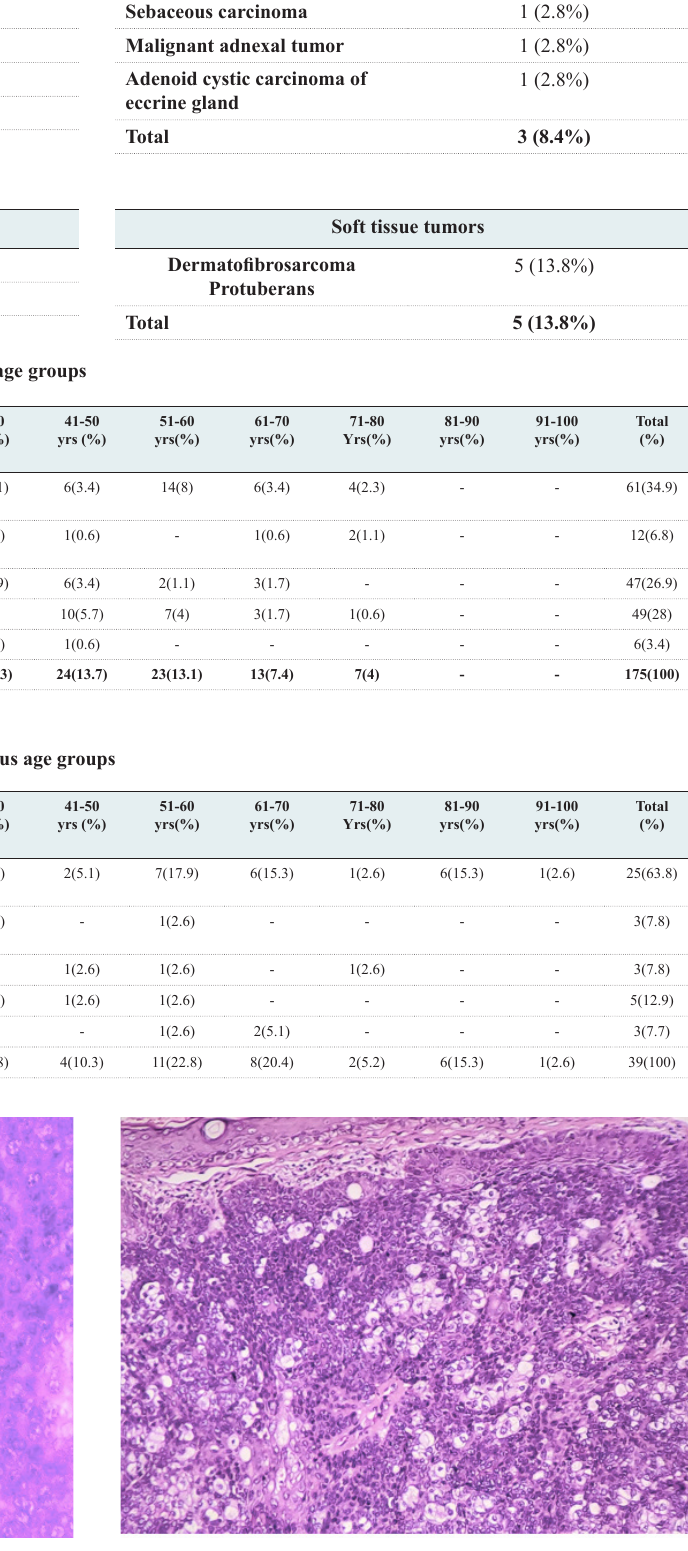
Figure 1: Pilomatricoma featuring transformation of basaloid cells into shadow cells (HE stain; X40).